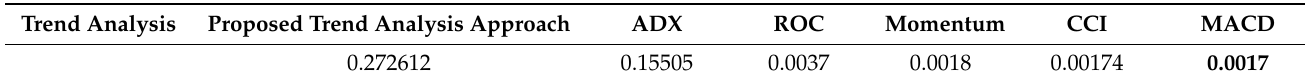
Table 13. Average computational time taken (in seconds) for proposed trend analysis strategies and technical